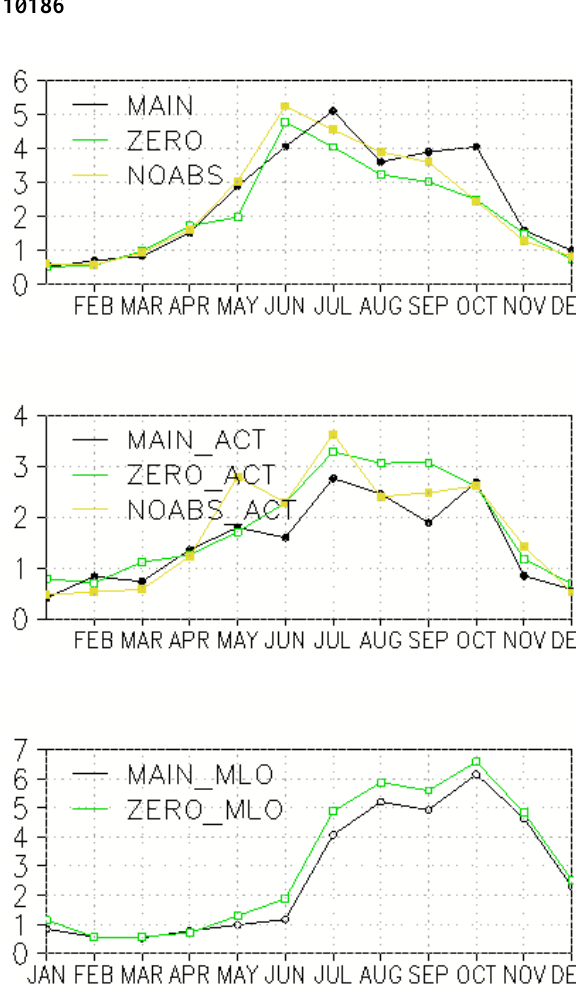
Figure 13. Rainfall in the area 75–80 ◦ E, 10–20 ◦ N in the simula- tions above) without aerosol–cloud activation (black: MAIN, green: ZERO, yellow: NOABS) and below with aerosol–cloud activation (black: MAIN_ACT, green: ZERO_ACT, yellow: NOABS_ACT), 7-year monthly means.